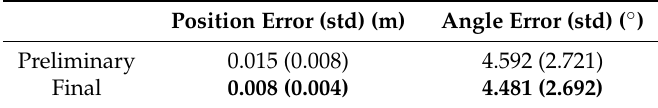
Table 4. Comparison of the preliminary and final model on the test set.